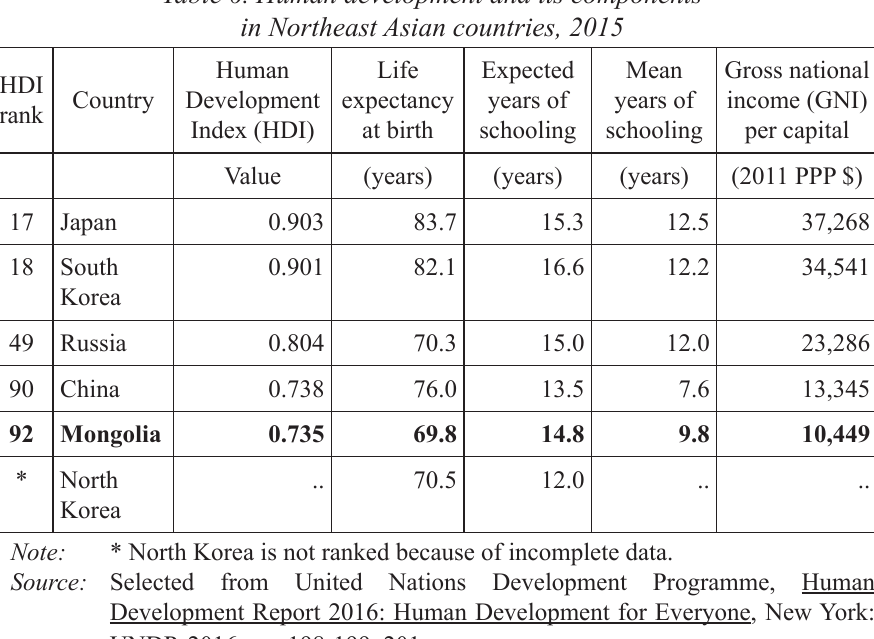
Table 6. Human development and its